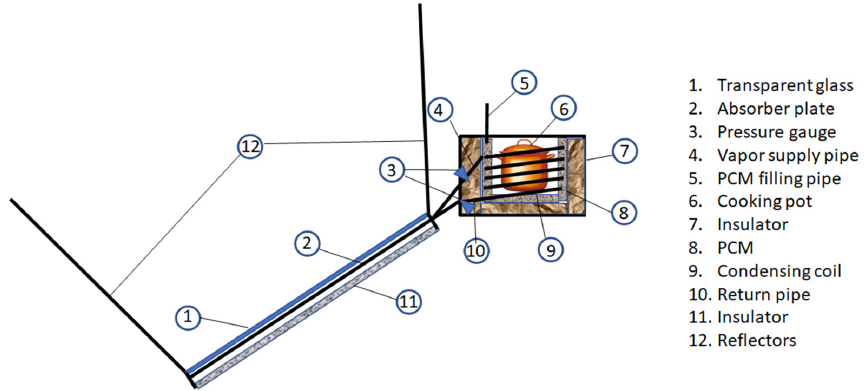
Figure 2. Solar cooker (SC) with indirect cooking method. A fluid with high thermal capacity is heated by the sun and transfers heat to the pot. By absorbing the heat PCM can prolong the cooking time with low sun irradiation.